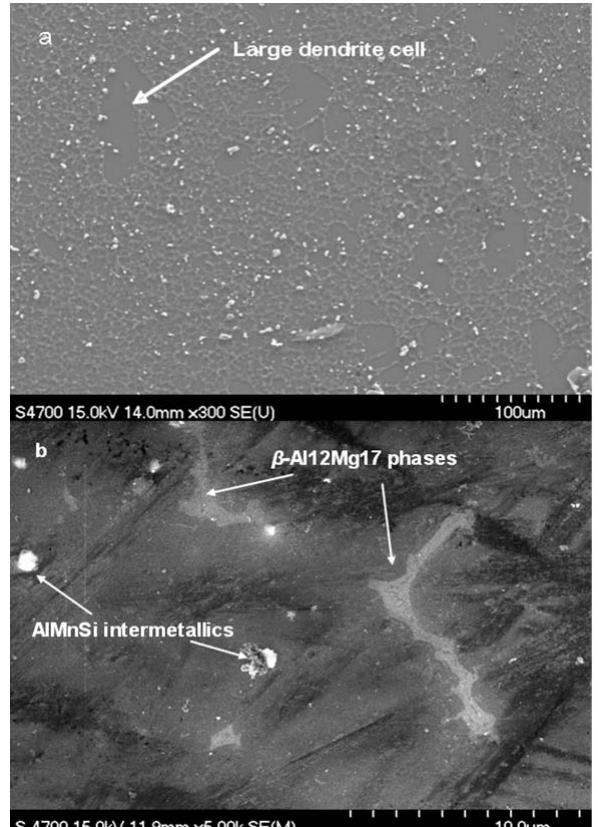
Figure 1. ( a ) Overall view of micro-structure; ( b ) Higher magnification of the micro-structure [1].